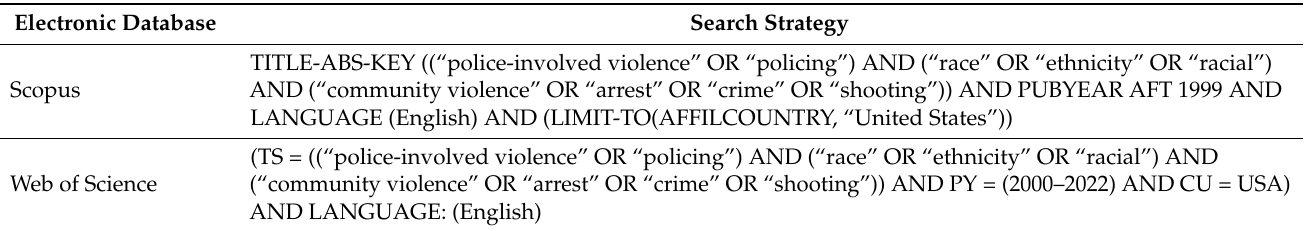
Table 1. The search strategy was used for each electronic database. Electronic Database Search Strategy